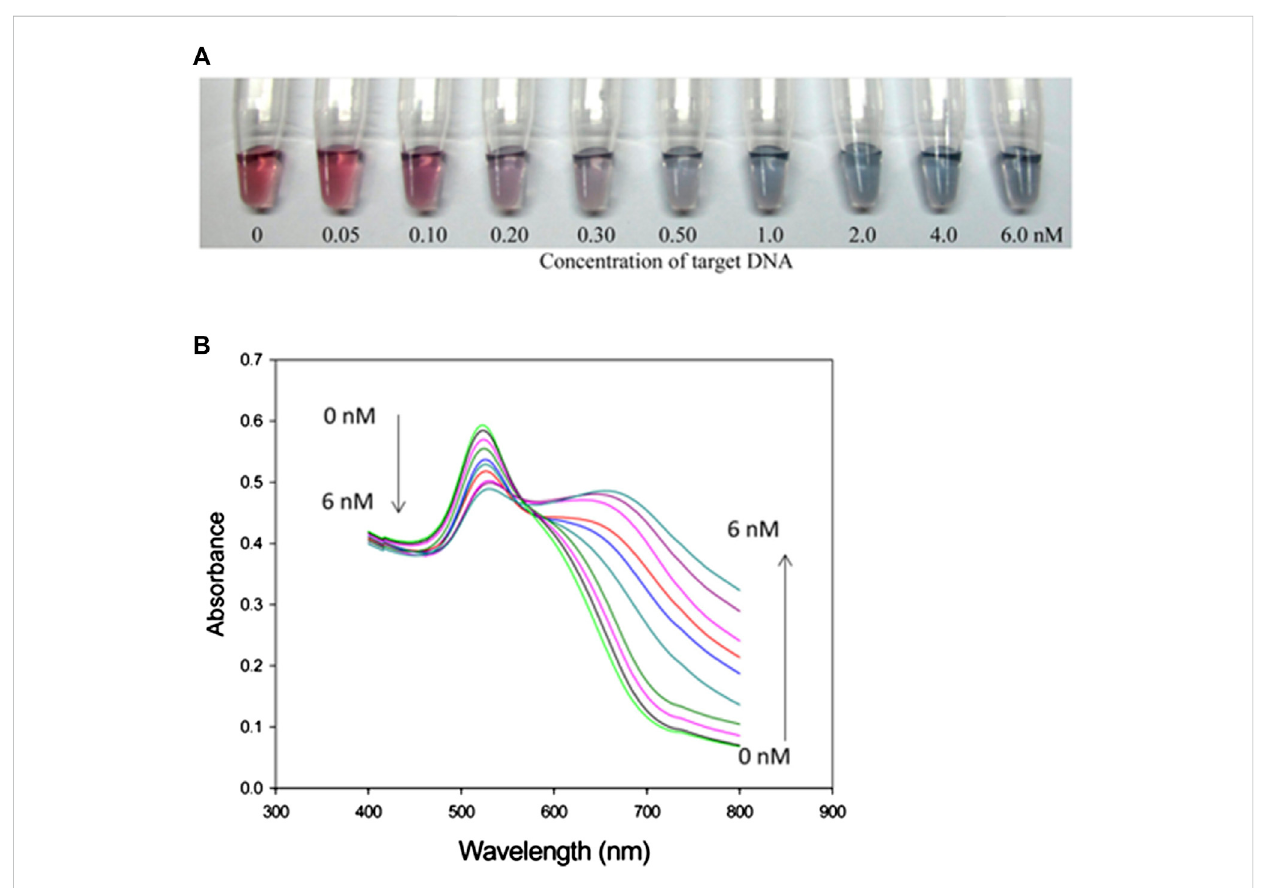
FIGURE 6 (A) Calorimetric response of concentration of DNA (0-6 nM), (B) absorption spectrum as a function of wavelength of electrolyzed DNA (Liu et al.,2013).